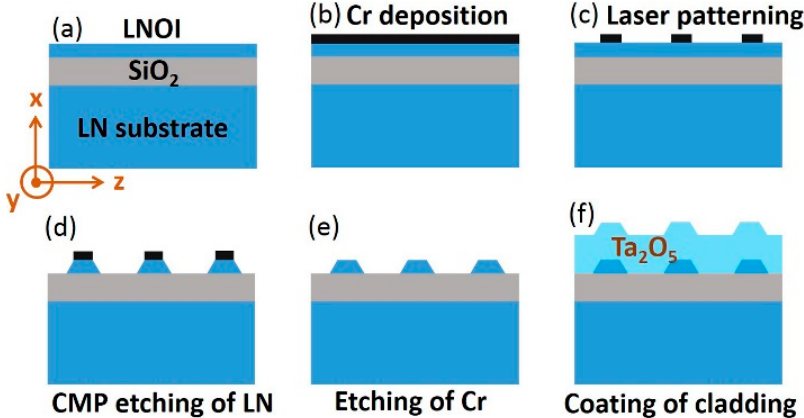
Figure 1. Process flow of lithium niobate on insulator (LNOI) waveguide fabrication. ( a ) Structure of LNOI substrate; ( b ) Depositing a layer of Cr film on LNOI; ( c ) Patterning the Cr film by femtosecond laser ablation for producing the mask of waveguides; ( d ) Transferring the mask pattern to LNOI by chemo-mechanical polish; ( e ) Removing the remaining Cr film by wet chemical etching; ( f ) Coating the waveguides with a layer of Ta 2 O 5 to form the cladding.